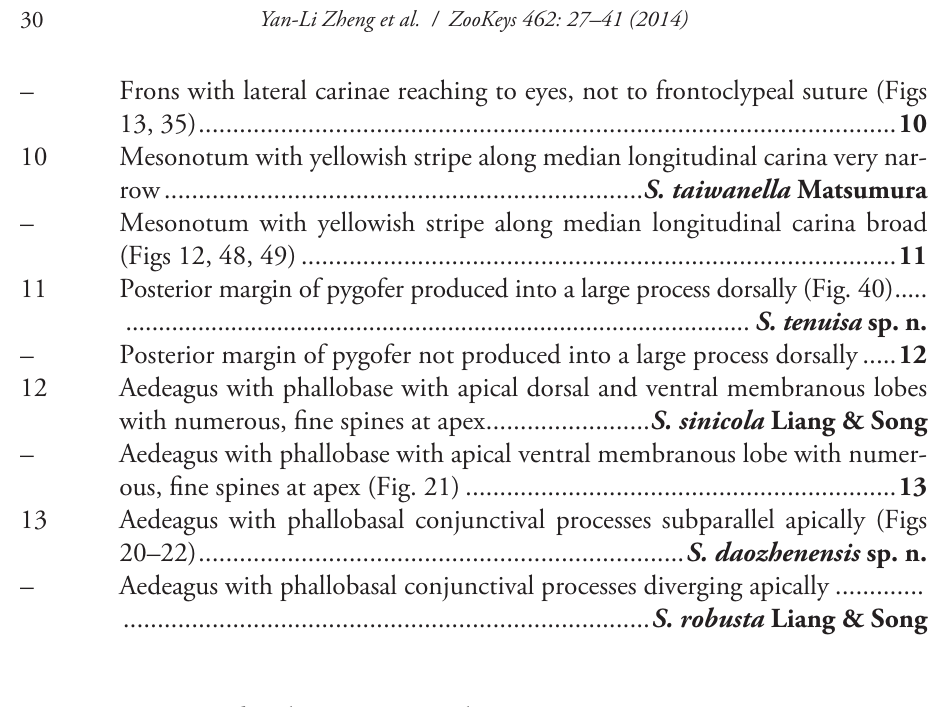
Description. Measurement. ♂ , BL: 15.7 mm; HL: 2.4 mm; HW: 1.5 mm; FWL: 11.8 mm. Coloration. General color brown, marked with fuscous and ochraceous (Figs 45–47). Vertex brown with median carina ochraceous, lateral margins brown. Ge- nae brown, eyes brown, ocellus yellowish, antenna brown and the areas surrounding ocellus and antenna beneath eye yellowish. Frons yellowish. Postclypeus, anteclypeus black. Pronotum pale brown, lateral, ventrally curved areas with a yellowish band. Me- sonotum pale brown scattered white spots and yellowish at the apex. Thorax ventrally at the fore femur brown, the other area pale green. Abdomen dorsally dark, with yel- lowish band on disc, ventrally dark. Forewings venation brown and stigma dark. Legs dark, tibiae with green rings. Genitalia black. Head and thorax. Head (Figs 1, 45–47) shorter than pronotum and mesonotum combined (0.75:1). Vertex (Fig. 1) with median carina very faint, only conspicuous at apex and base; lateral carinate margins curved. Frons (Fig. 2) with lateral carinae almost reaching to to frontoclypeal suture. Mesonotum (Figs 1, 45–47) tricarinate on disc, lateral carinate curved towards media carinate at the front. Forewing (Figs 4, 45–47) longer than widest part (2.85:1), venation as in Fig. 4; hindwing longer than widest part (2.43:1), venation as in Fig. 5. Spinal formula of hind leg 8-12-11. Male genitalia. Anal tube (Figs 6, 7) large, nearly triangular in lateral view (Fig. 41), large, long, round in dorsal view (Fig. 39), ratio of length to width at middle about 2:1. Pygofer (Fig. 7) large and broad in lateral view, posterior margin with a